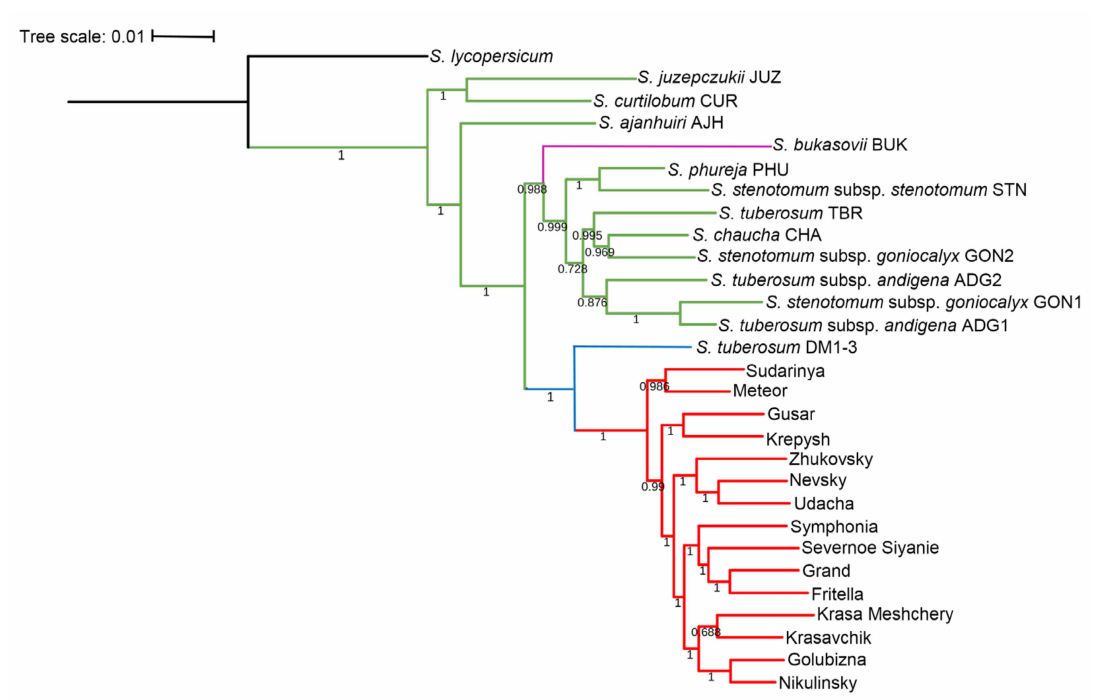
Figure 3. Genetic differentiation within two subsets of South American landraces and Russian potato cultivars accessions, as well as the reference tomato and potato DM1-3 genomes, built by Orthofinder program. Branches leading to Russian cultivars are shown in red, to South American cultivated species accessions—in green. Wild species S. bukasivii (BUK) is shown by magenta branch. The branch corresponding to the reference genome (DM1-3 PGSM v4.03) is shown in blue, the S. lycopersicum outgroup is shown in black. The scale bar is shown in the upper left corner, the numbers at the nodes correspond to the Shimodaira–Hasegawa-like support